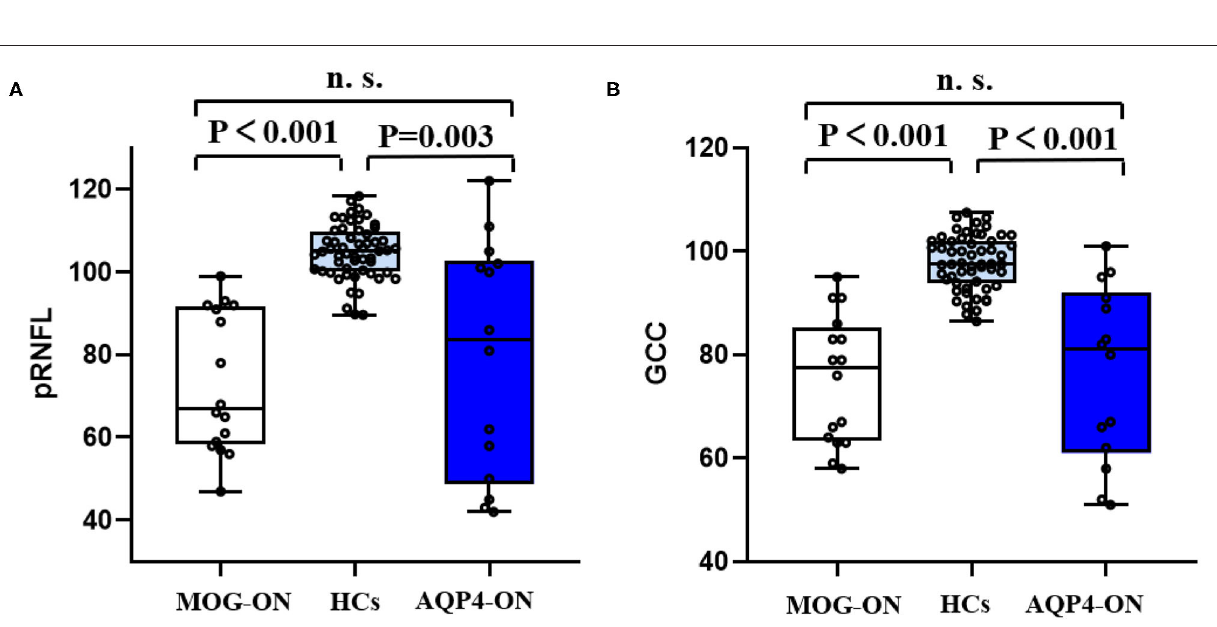
was also predicted by disease duration, age, and number of